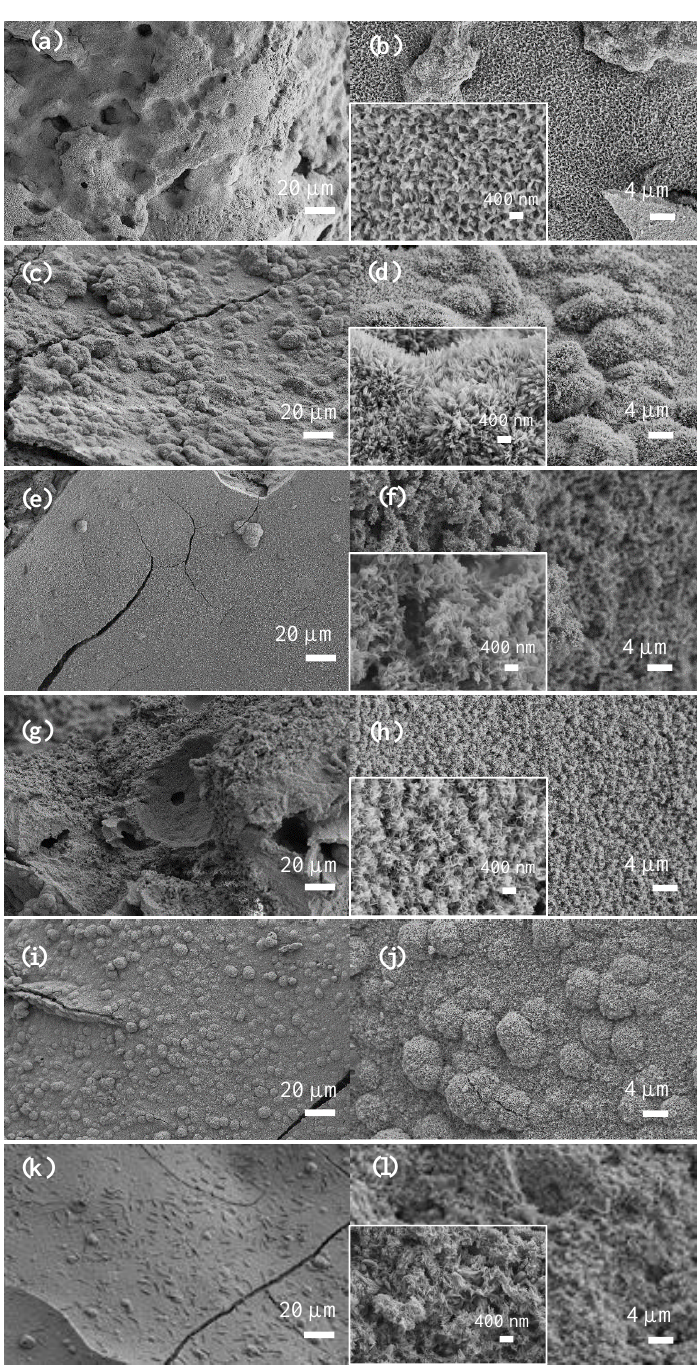
Figure 7. SEM micrographs of the SBF-treated bioactive glass scaffolds for 30 d ( a , b ) B3; ( c , d ) 0.1 hBN-B3; ( e , f ) 0.2 hBN-B3; ( g , h ) 0.5 hBN-B3; ( i , j ) 1 hBN-B3; ( k , l ) 2 hBN-B3.